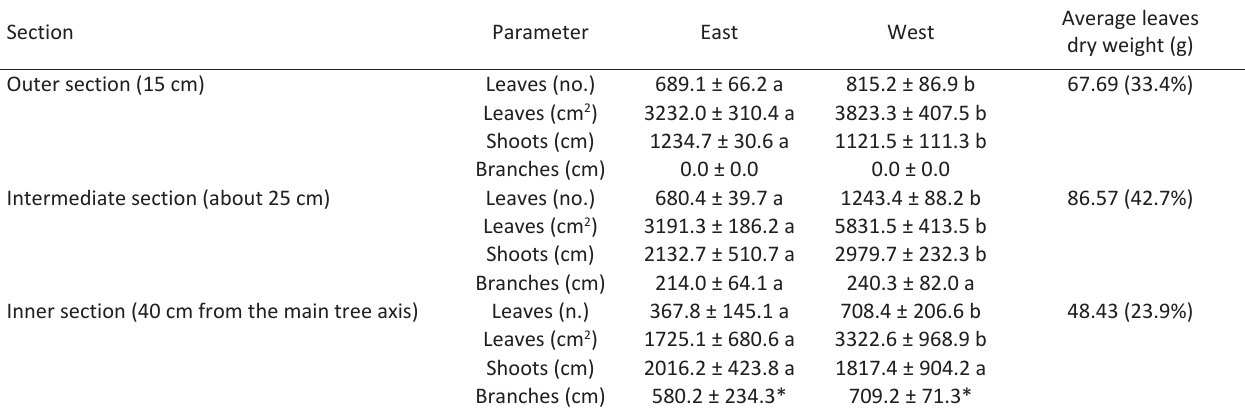
Table 3 - Partition of components (leaves number and surface, shoots and branches length) of the three canopy transversal sections in olive trees of cv. Arbequina (Tombolo farm, 2018) measured in the sampling units (1 unit = 1 m 2 ), side (Est/West) (average ± S . D .)